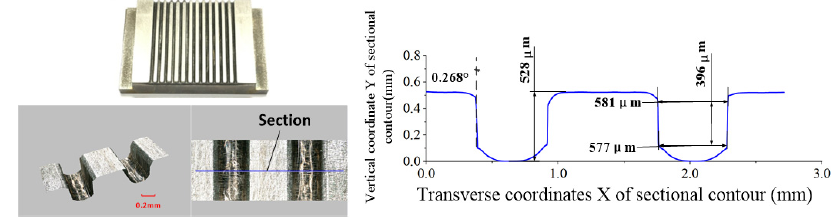
Figure 13. Specimen of cathode machining group grooves with 0.191 mm front edge widths.